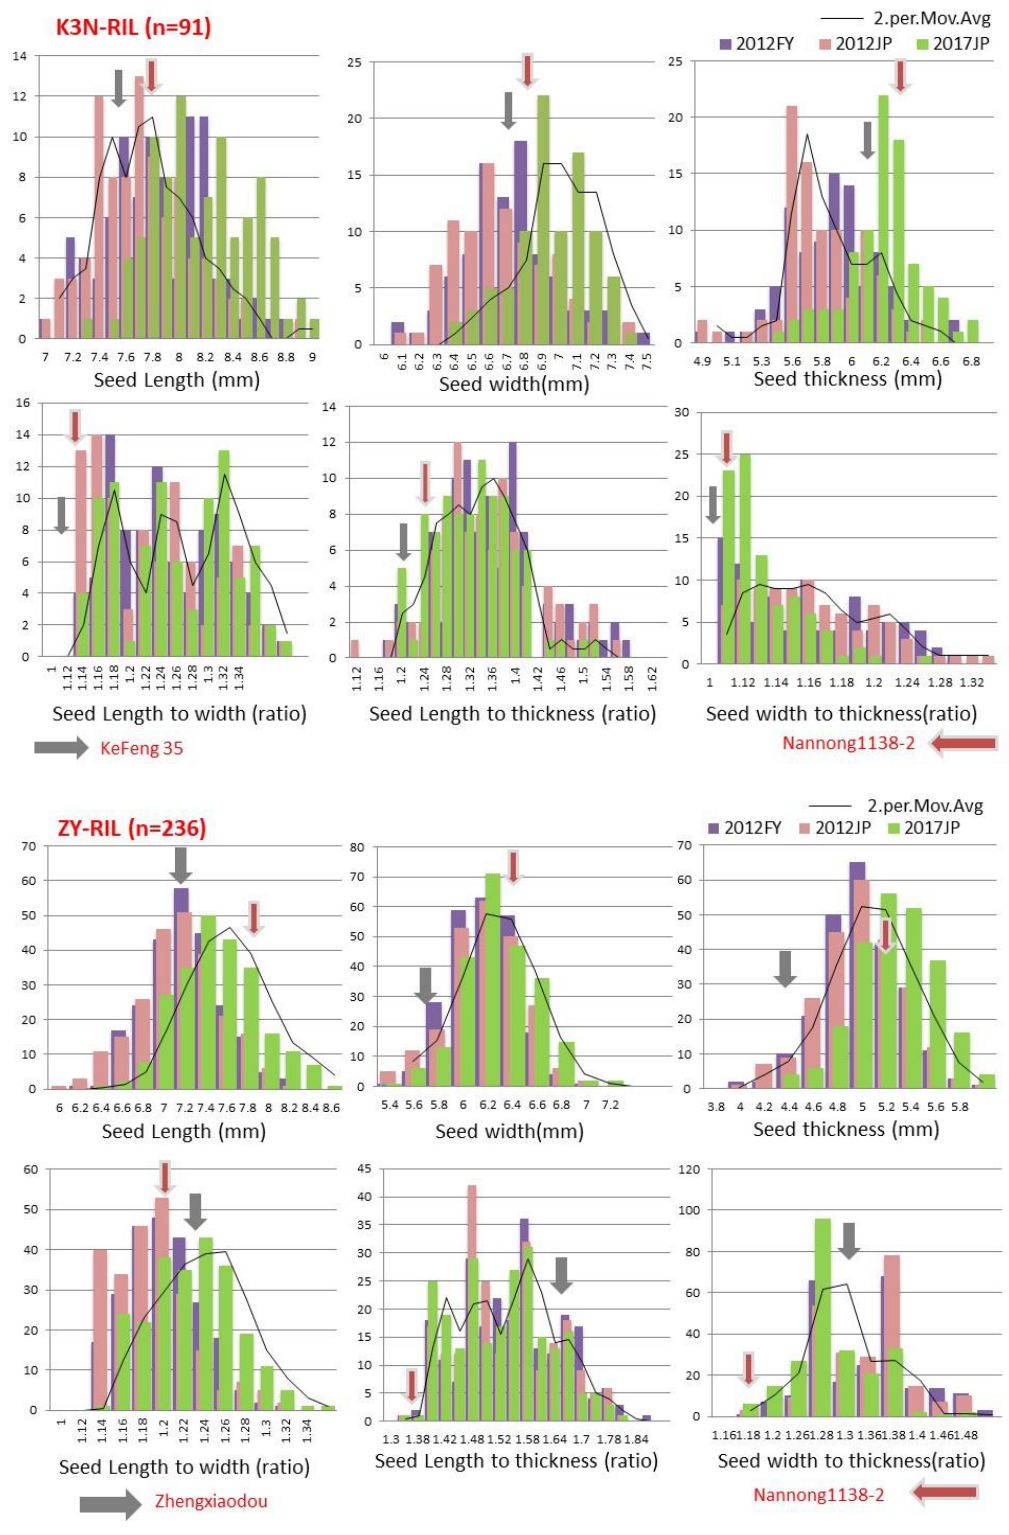
Figure 1. Frequency distribution of seed length (SL), seed width (SW), seed thickness (ST), seed length-to-width (SLW), seed length-to-thickness (SLT), and seed width-to-thickness (SWT) in ZY and K3N recombinant inbred line (RIL) populations across three different environments ( 2012FY, 2012JP, and 2017JP). Trend lines show the moving average. Arrows represent mean value of corresponding parent. Horizontal and vertical axis represent trait value and number of genotypes, respectively.